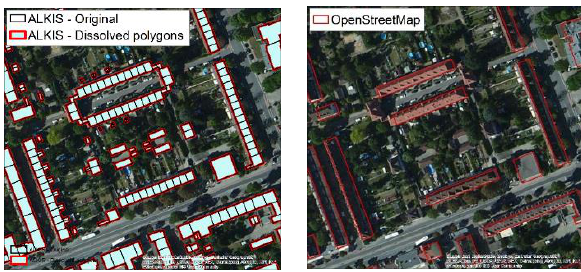
Figure 2. Original and dissolved ALKIS building polygons (reference data; left) and OSM building footprints